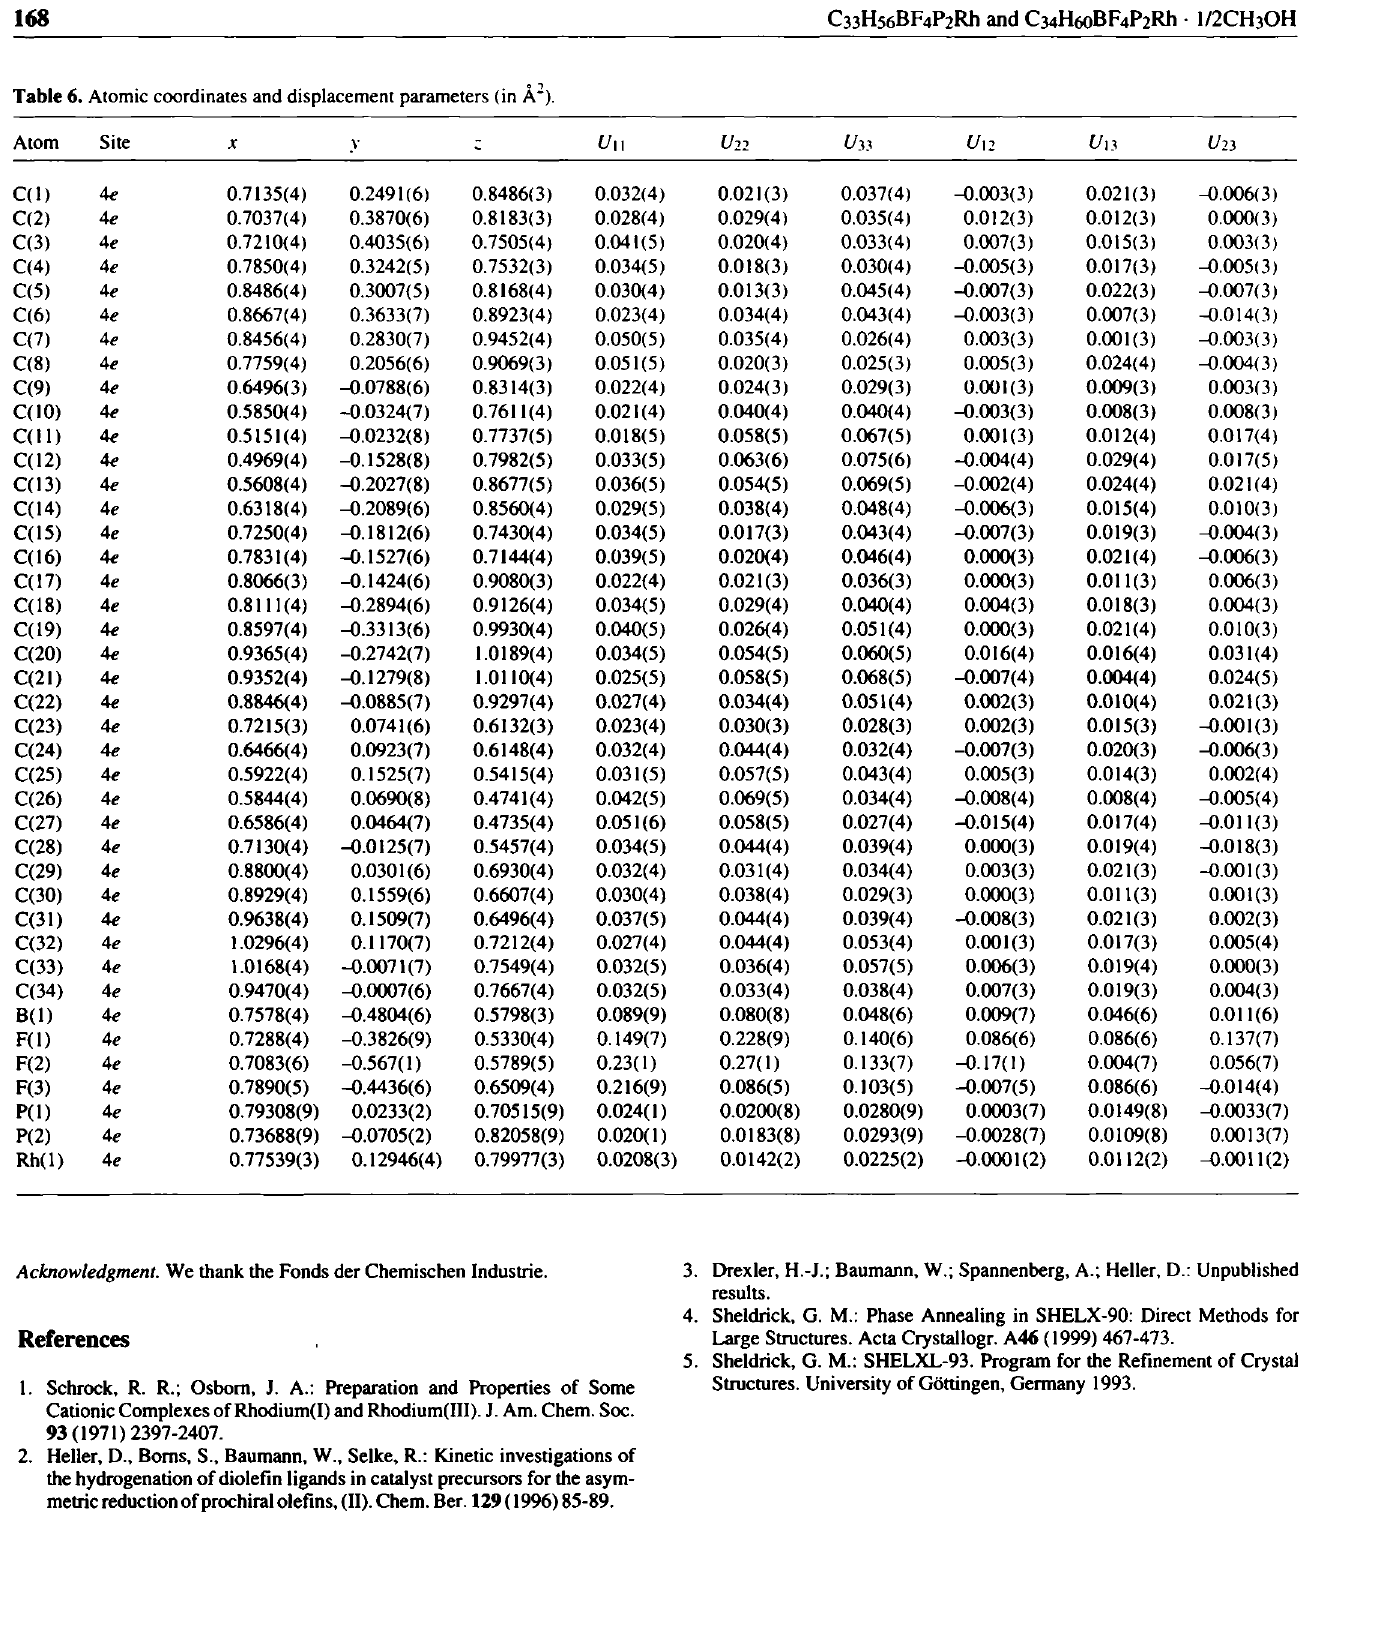
Table 6. Atomic coordinates and displacement parameters (in A 2